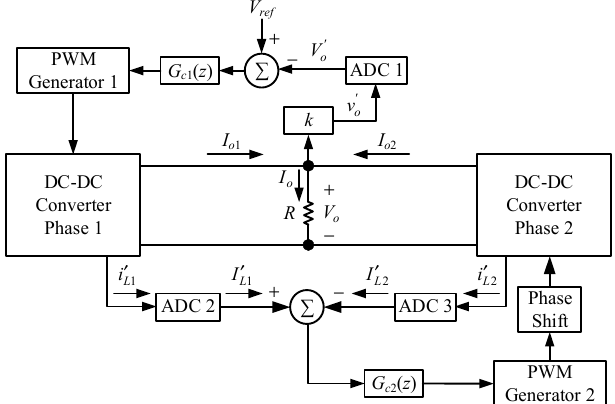
Figure 12. Proposed current-balancing control strategy (ADC: analog-to-digital converter; PWM: pulse-width modulation).